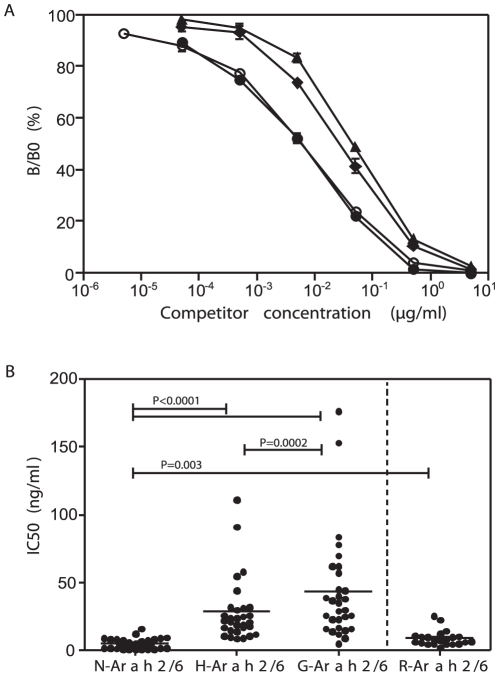
Effect of thermal treatment on the IgE binding capacity of Ara h 2/6.
A. IgE capture inhibition curves obtained for sera #05-0209 with N-Ara h 2/6 (•), H-Ara h 2/6 (⧫) or G-Ara h 2/6 (▴). IgE binding capacities of native and heated processed Ara h 2/6 was assessed by competitive assays in the IgE capture format. Inhibition was performed into microtiter plates coated with anti-IgE, and previously incubated with allergic patient sera at convenient dilution. Competition was then conducted by adding increasing concentrations of competitors at the same time as biotinylated N-Ara h 2/6. Competition obtained with Ara h 2/6 purified from roasted peanut is shown as a clear circle. B. Analysis of IC50 (ng/ml) values obtained using an IgE capture inhibition assay with native and heat processed Ara h 2/6 as competitors using 30 individual sera from peanut-allergic patients. Increase in IC50 value corresponds to a decrease in IgE-binding capacity. R-Ara h 2/6: mix of Ara h 2 and Ara h 6 purified from roasted peanut. Bars indicate a significant difference between the 2 corresponding treatments (P<0.05, non-parametric Wilcoxon signed rank test).